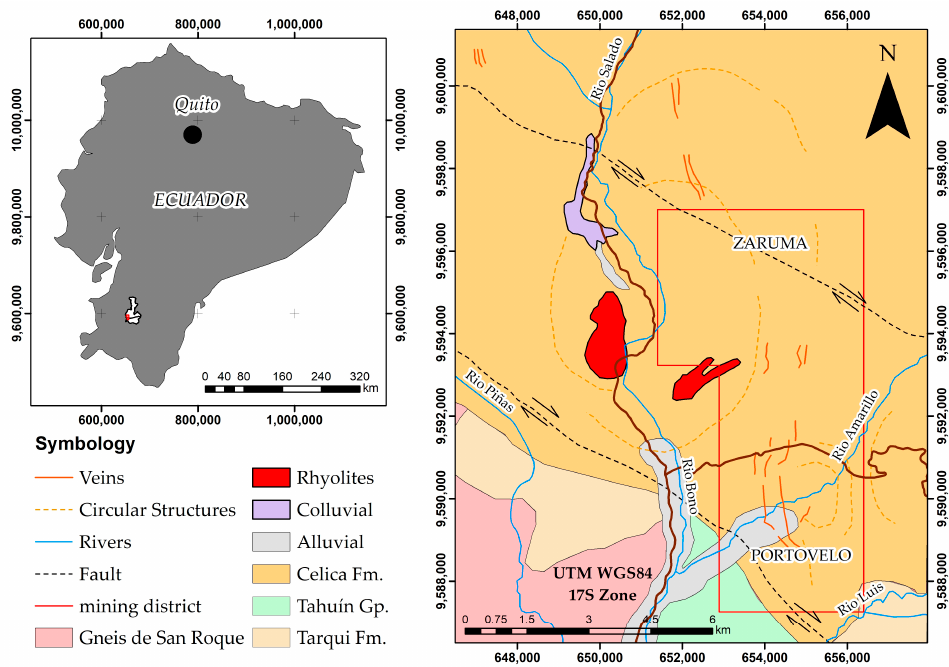
Figure 2. Schematic geological map of the Zaruma-Portovelo mining district. Adapted from [49,52]. On the whole, Zaruma, Portovelo, Piñas, Atahualpa (Paccha) and Chilla cantons